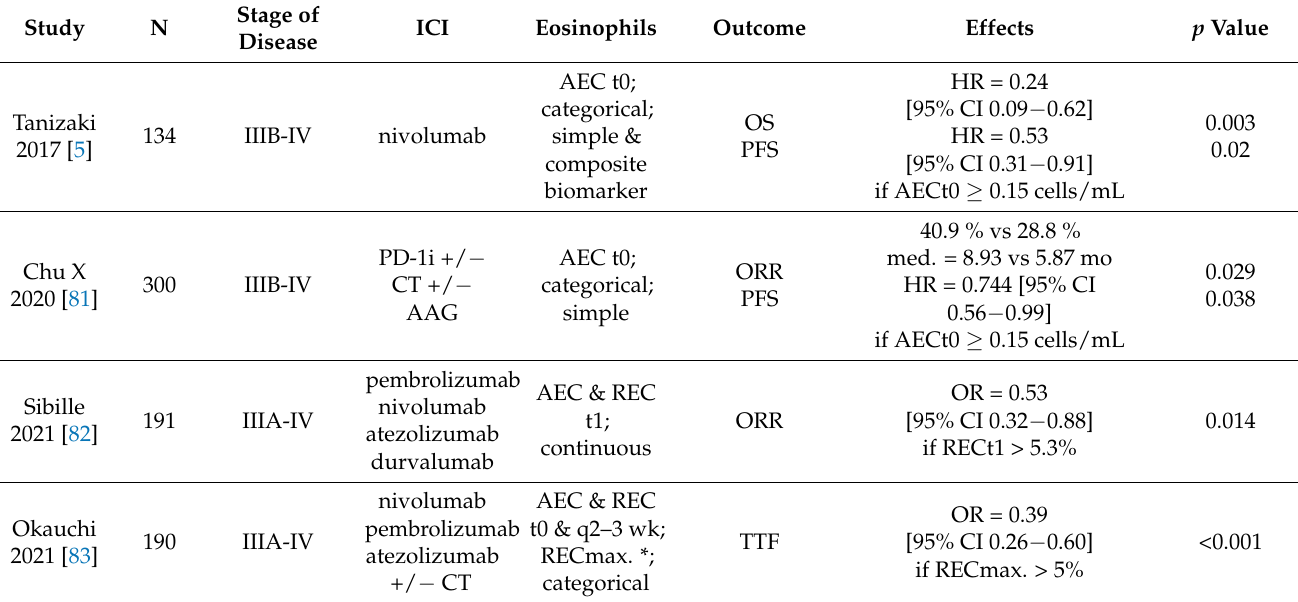
Table 1. Studies on the association between outcomes of NSCLC patients treated with ICI and blood eosinophils. This table illustrates the heterogeneity of study objectives and of evaluation criteria for eosinophilia: continuous/categorical variable; timing of evaluation; biomarker used alone (simple) or in combination with others